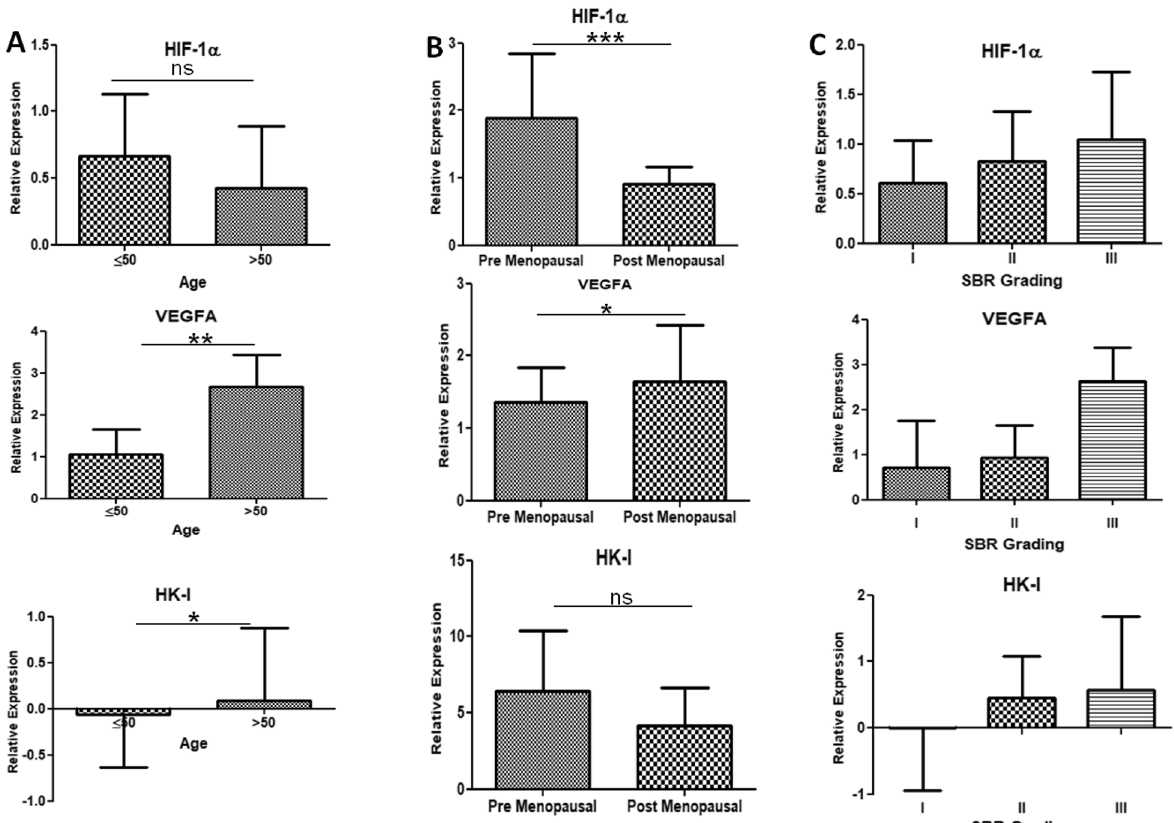
Fig. 6 A Relative mRNA expression of VEGFA and HK-I was greater in higher age groups (> 50 years) ( B ) VEGFA was also higher in Post-menopausal patients ( C ) HIF-1A, VEGFA & HK-I were seen to be greater in higher histological grade